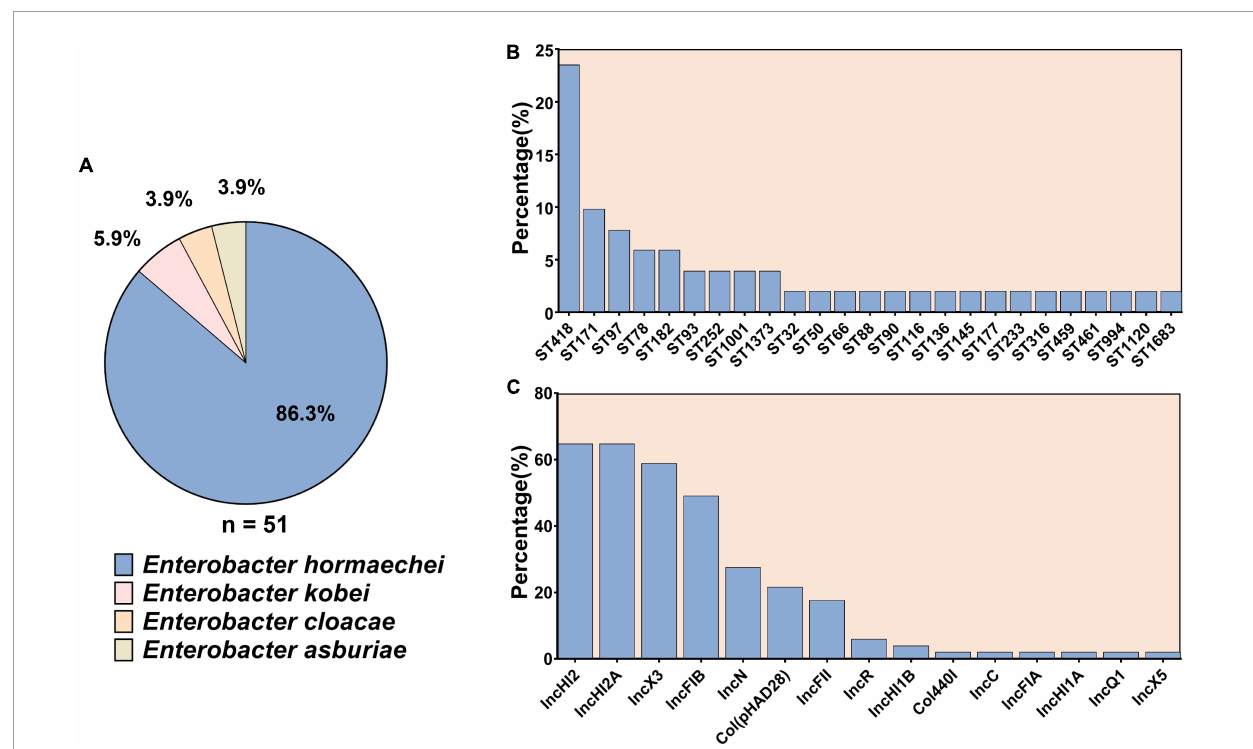
FIGURE1 The subspecies and sequence types of 51 carbapenem-resistant Enterobacter cloacae complex as well as the distribution of plasmid replicons among them. (A) The subspecies of 51 carbapenem-resistant Enterobacter cloacae complex. (B) Sequence types of the 51 carbapenem-resistant Enterobacter cloacae complex strains. (C) Plasmid replicons among the 51 carbapenem-resistant Enterobacter cloacae complex.